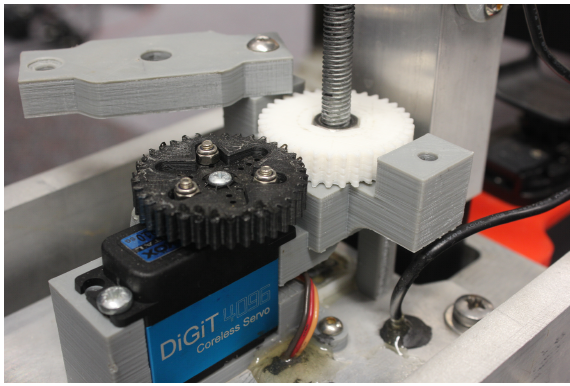
Figure 6. Photo of the protraction